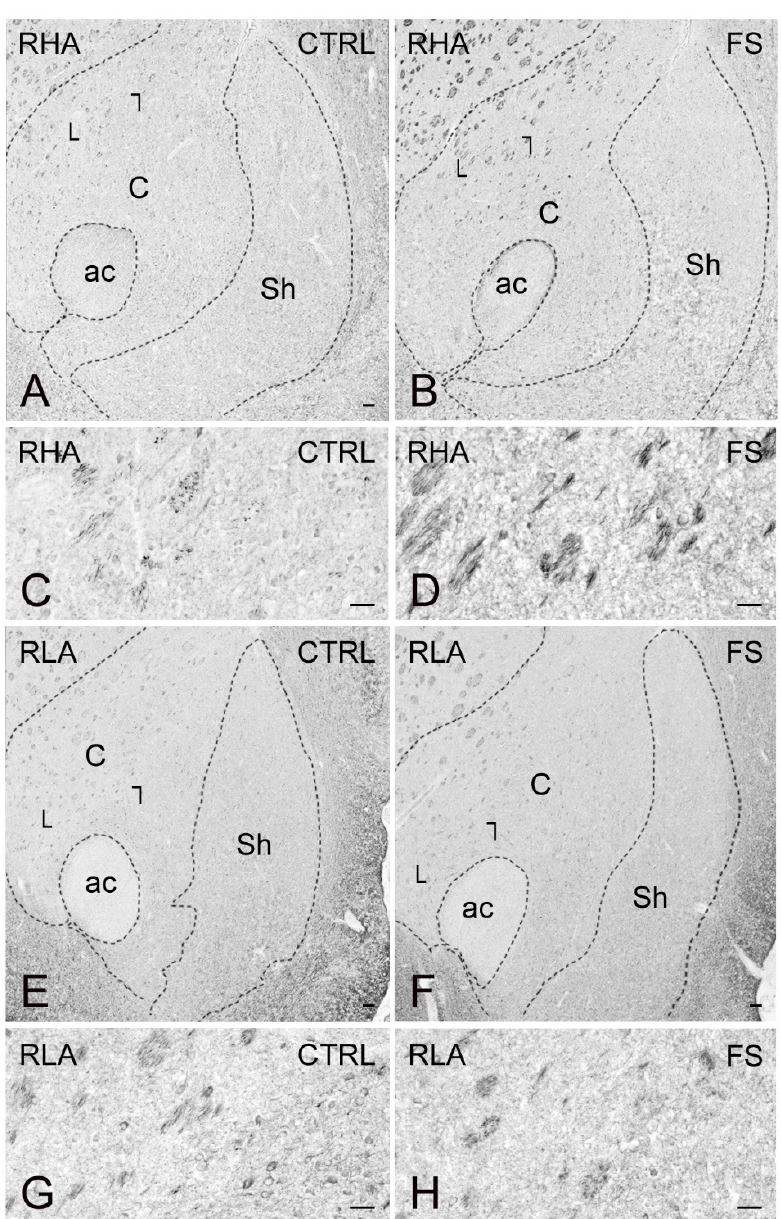
Figure 11. trkB receptor-like immunoreactivity (trkB-LI) in the nucleus accumbens (Acb) of RHA ( A – D ); and RLA rats ( E – H ) under baseline conditions (CTRL) and after a 15 min session of forced swimming (FS). ( A , B , E , F ) low power view of the Acb. Dashed lines mark the boundaries of the Acb shell (Sh) and core ( C ) subregions. Areas squared in ( A , B , E , F ) indicate the microscopic field in ( C , D , G , H ), respectively. ac, anterior commissure. Scale bars: ( A , B , E , F ) = 250 µm; ( C , D , G , H ) = 25 µm. As shown in Figures 10–12, the trkB-LI was localized to neuronal perikarya, proximal neuronal processes and nerve fibers. In the VTA, trkB-labeled large neuronal perikarya and dot-like elements were observed in RHA rats, particularly after FS (Figure 10). In both the shell and core compartments of the Acb, trkB-positive neurons stood out within a diffuse labeling of the neuropil (Figure 11). Except for the molecular layer, numerous trkB-labeled neuronal cell bodies and long neuronal processes were observed in all the layers of the IL/PL (Figure 12) and ACg (not shown) subregions of the